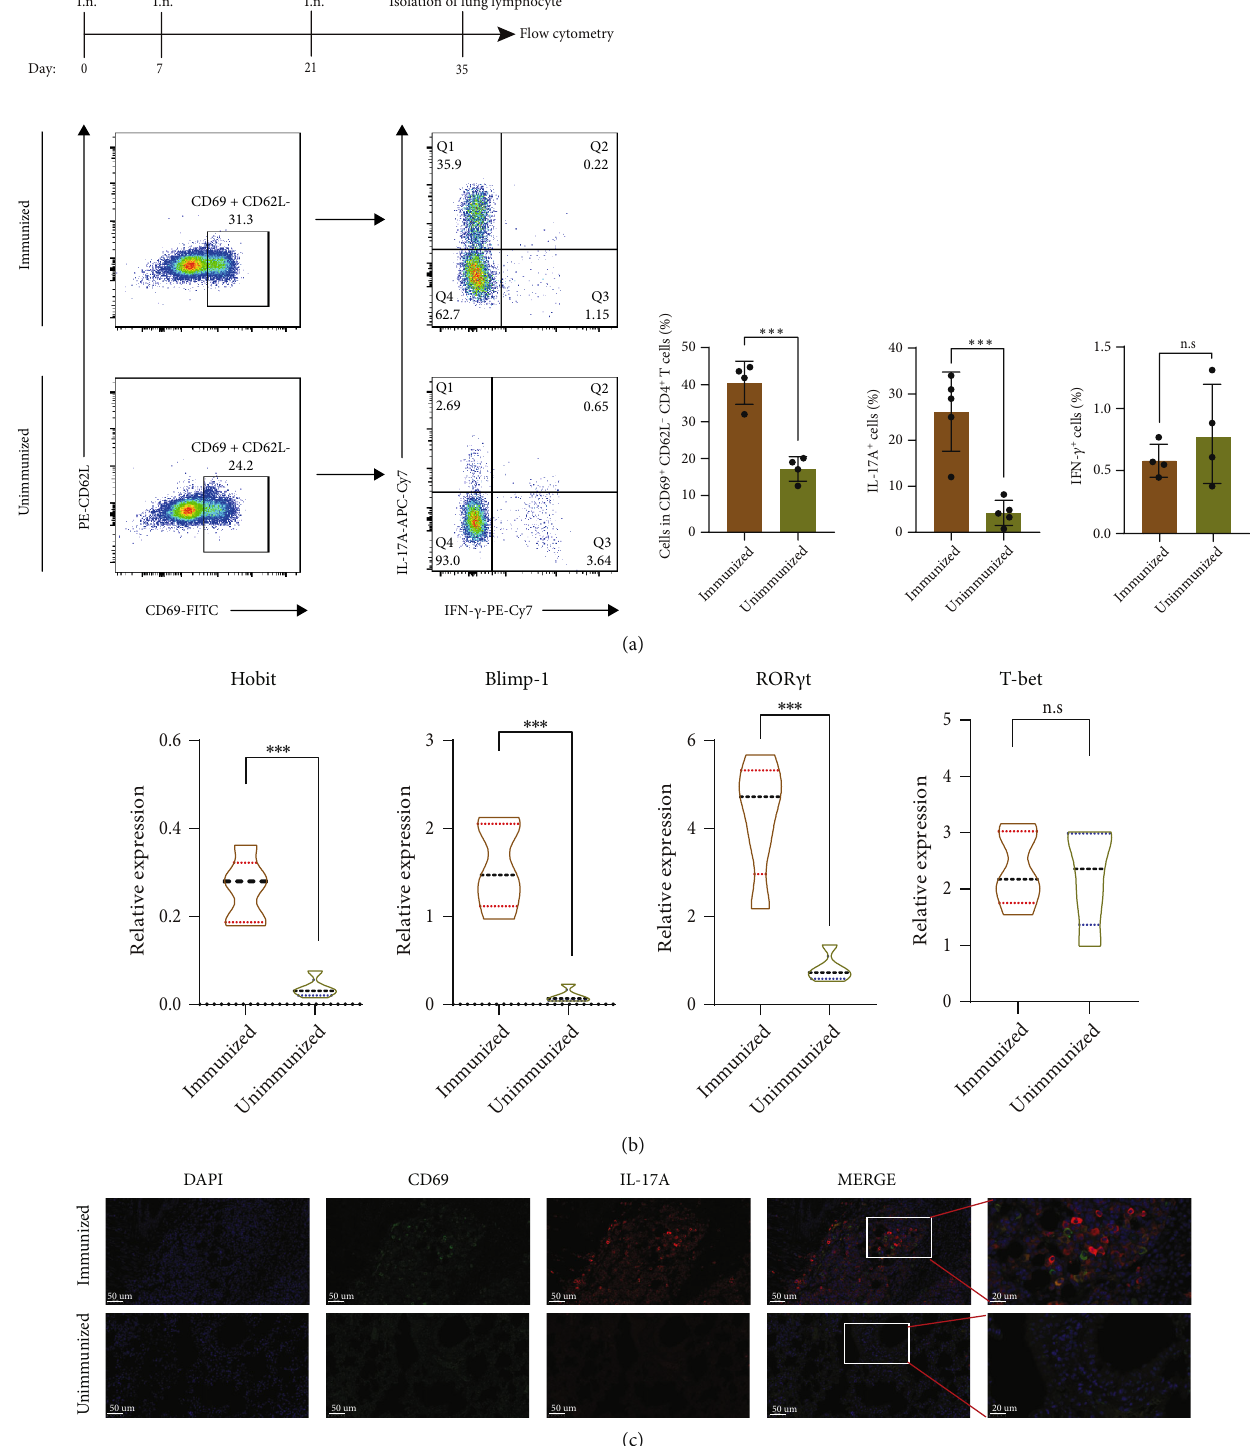
Figure 3: Intranasal vaccination with rePcrV primes the CD4 + T cells response. (a) Schematic of the experimental protocol. RM Representative intracellular staining pro fi les and pooled data of IL-17A and IFN- γ in CD4 + CD44 + CD69 + CD62L - T cells in the lungs of immunized mice (rePcrV + curdlan i.n.) or unimmunized mice ( n = 4 ). (b) Hobit , Blimp-1 , ROR- γ t , and T-bet expressions of CD4 + T cells in the lung tissues of immunized mice (rePcrV + curdlan i.n.) or unimmunized mice ( n = 4 ). (c) Representative immuno fl uorescence images of the lung tissues stained with DAPI (blue), anti-CD69 (green), and anti-IL-17A (red) from immunized mice (rePcrV + curdlan i.n.) or unimmunized mice ( n = 4 ). Data are presented as mean ± SEM . P values were calculated by Student ’ s t -test. ∗ P < 0 : 05 ; ∗∗ P < 0 : 01 ; ∗∗∗ P < 0 : 001 ; ∗∗∗∗ P < 0 : 0001